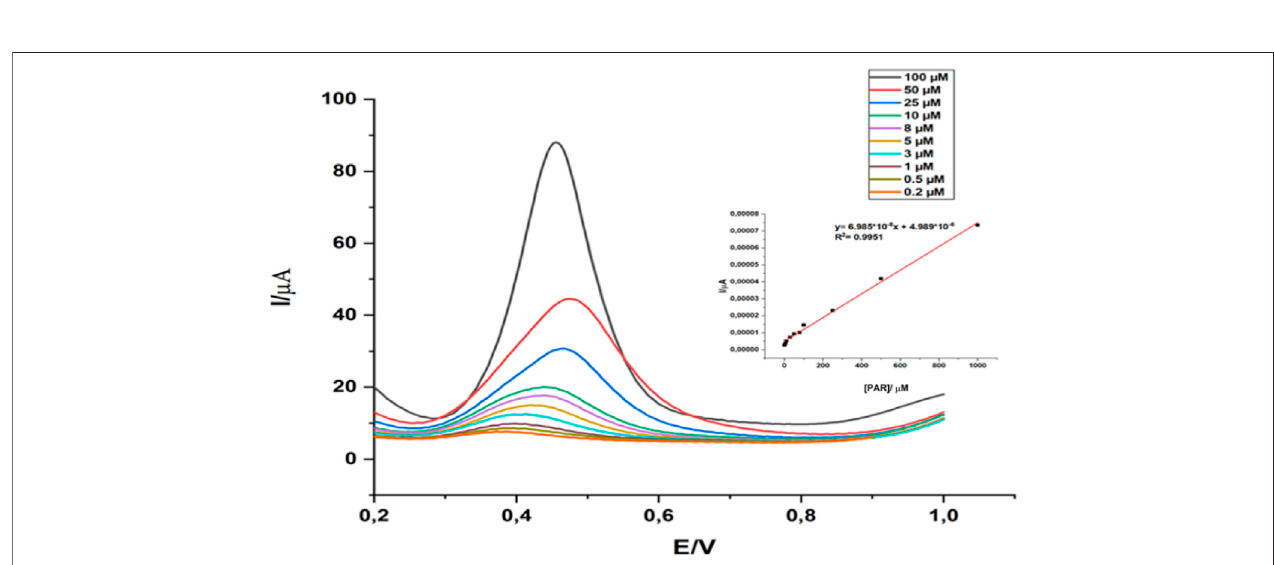
FIGURE7| GCE\gCN-AgPVPresponsetovariousconcentrationsofPARinPBS(pH=6)andlinearcalibrationplot(concentrationofPAR vs .currentdensity)inset graph. E start = 0,20v; E end = 1,00 v; Pulse amplitude = 50,0 mV; E step = 4 mV; SQWV frequenvy = 30,0 Hz.